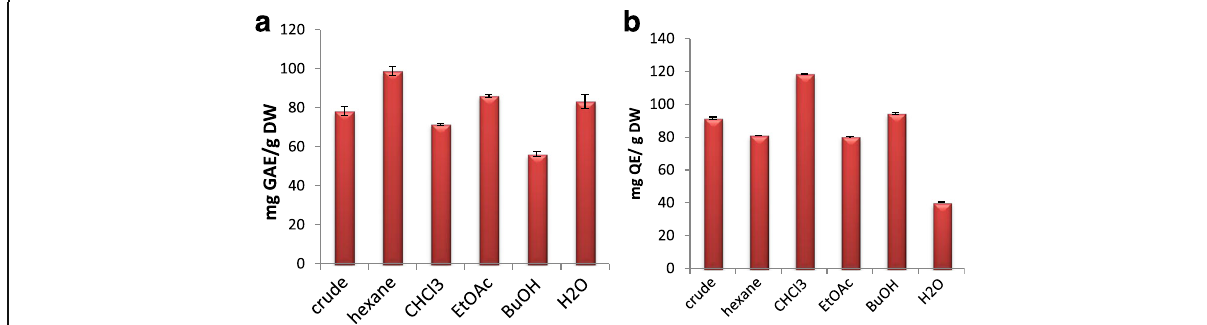
Fig. 2 Comparison charts of ( a ) Total phenolic content. b Total flavonoid content of ethanolic extract and solvent fractions of S.